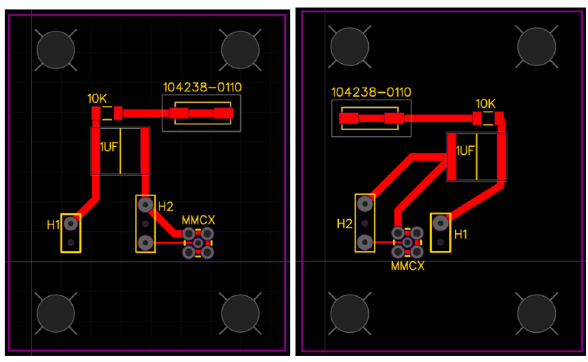
Fig. 3 PCB layouts of the top (left) and the bottom (right) passive bases dry nitrogen gas. The relative humidity was kept below 5% at 22 ◦ C during the assembly process. The SiPM-crystal assem-